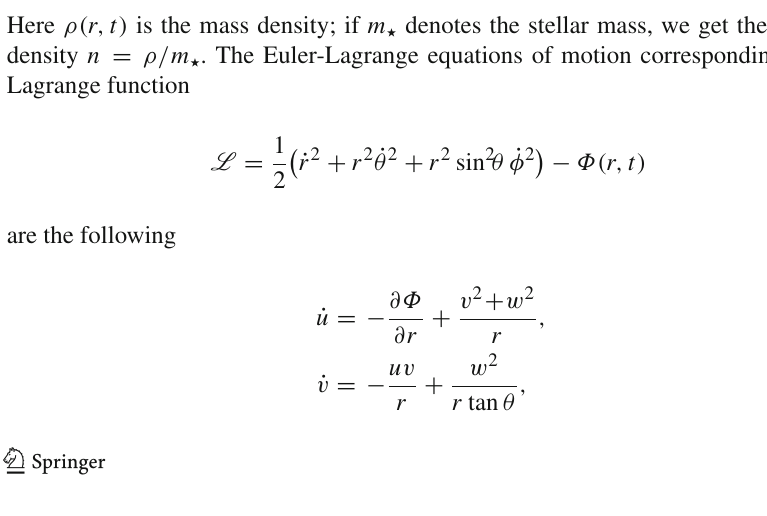
function f , is a function of r , t , u , v 2 + w 2 only due to spherical symmetry, and is normalised according to